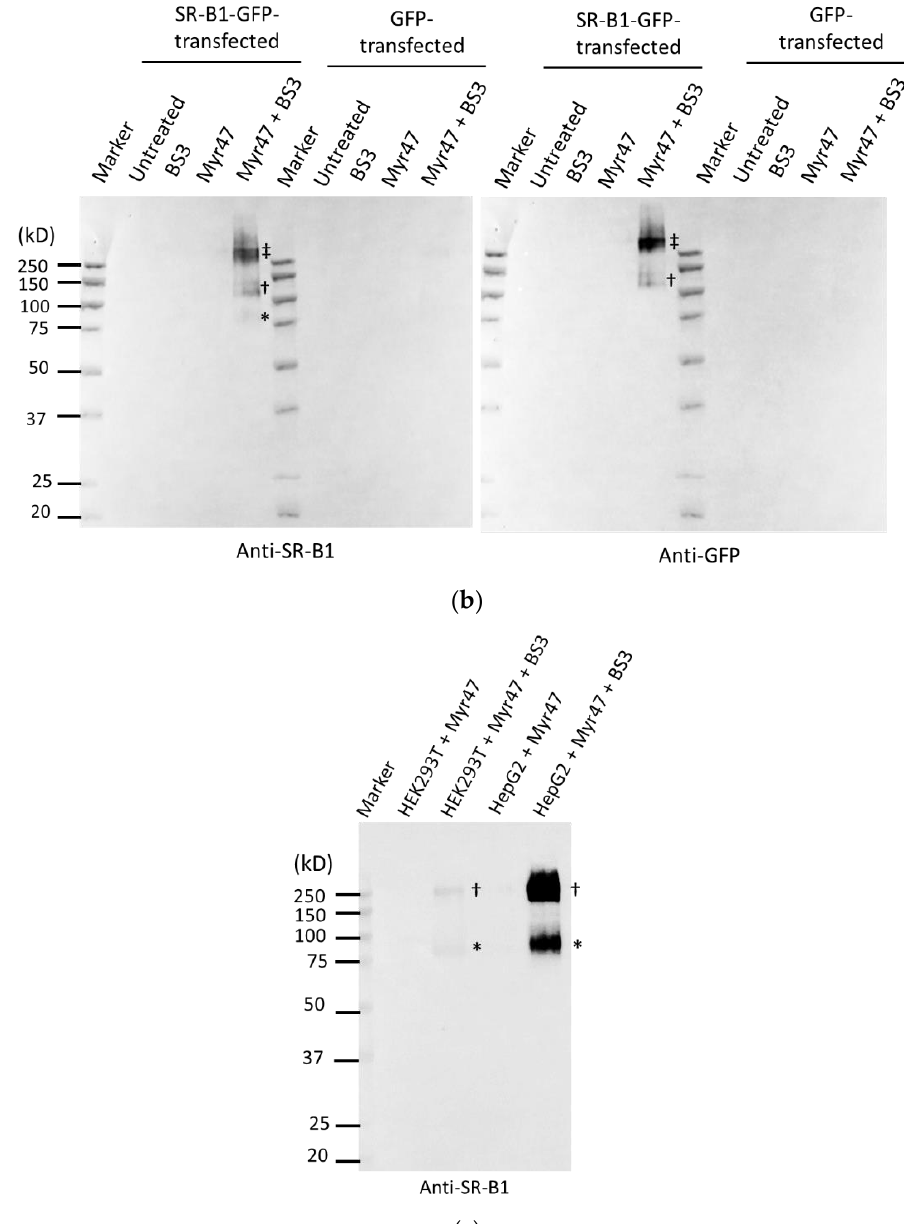
Figure 5. Crosslink of Myr47 and SR-B1-GFP or endogenous SR-B1. ( a ) Illustrated image of pull-down assays to detect SR-B1-GFP or endogenous SR-B1 crosslinked with biotinylated Myr47 using BS3. ( b ) Western blot analyses of pull-down samples prepared from HEK293T cells expressing SR-B1-GFP or GFP after sequential treatment with Myr47 and BS3. HEK293T cells transfected with indicated expression plasmids were incubated with or without biotinylated Myr47. Subsequently, they were treated with or without BS3. Cell lysates were prepared, and then they were applied for pull-down assays using streptavidin-coated beads and a magnet. The same volume (10 μ) of samples was applied for SDS-PAGE and Western blot analyses. Antibodies used for the detection of protein bands are indicated under the picture. Symbols, *, †, ‡ , indicate Myr47-binding endogenous SR-B1 multimer, SR-B1-GFP-monomer, and SR-B1-GFP multimer, respectively. ( c ) Western blot analyses of pull-down samples prepared from HEK293T or HepG2 cells expressing endogenous SR-B1 after sequential treatment with Myr47 and BS3. HEK293T or HepG2 cells were treated with biotinylated Myr47 and BS3. Then, pull-down assays and Western blot analyses were carried out as described in ( b ). Symbols, * and †, indicate Myr47-binding endogeous SR-B1 monomer and multimer, respectively.